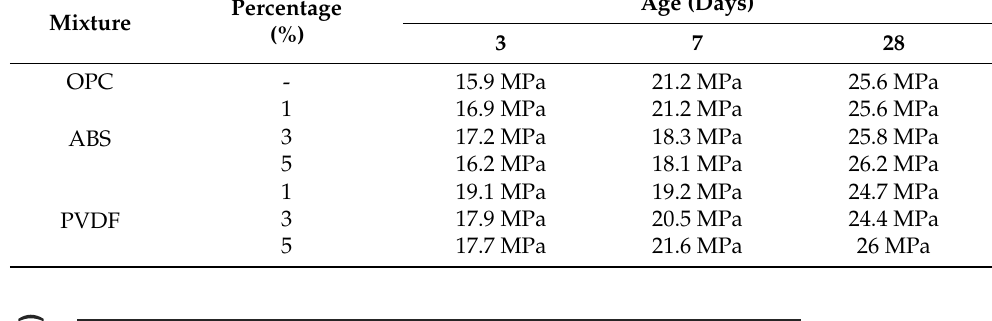
Table 7. Compressive strength by mixture addition and percentage.